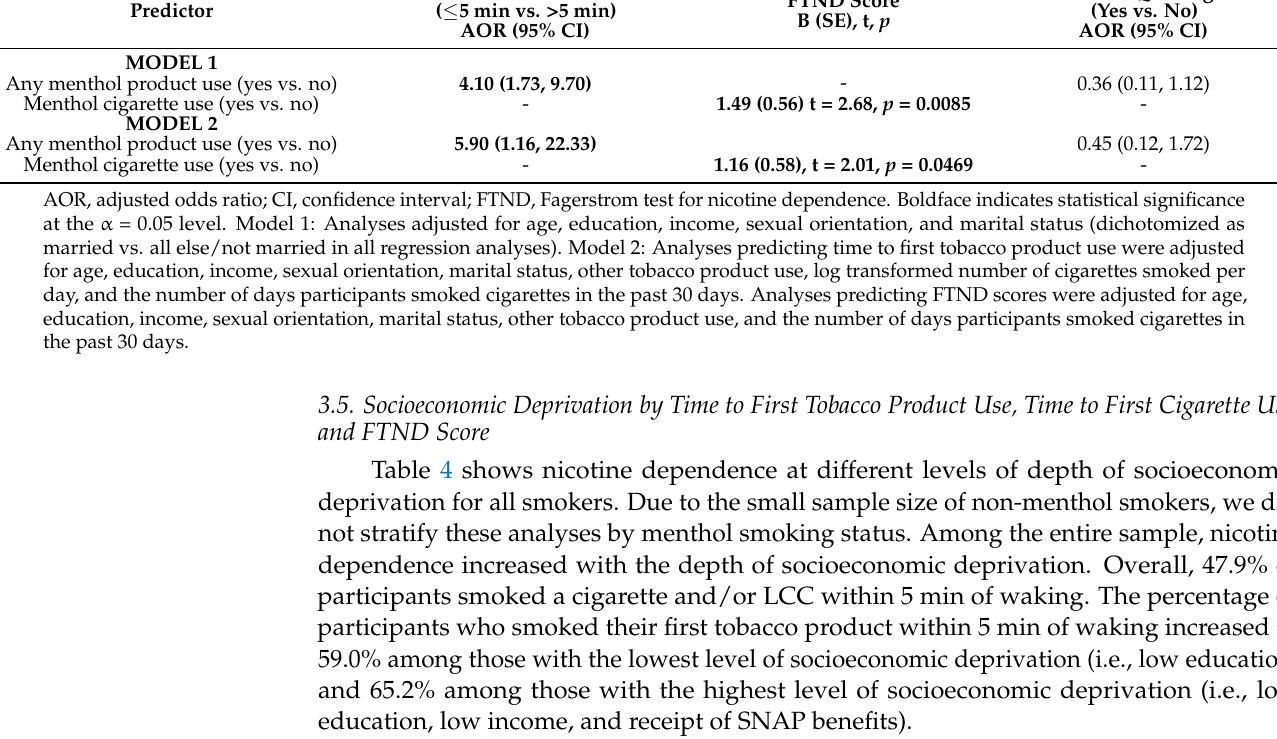
Outcomes Ever Tried to Quit Cigarettes FTND Score (Yes vs. No) B (SE), t, p AOR (95% CI)